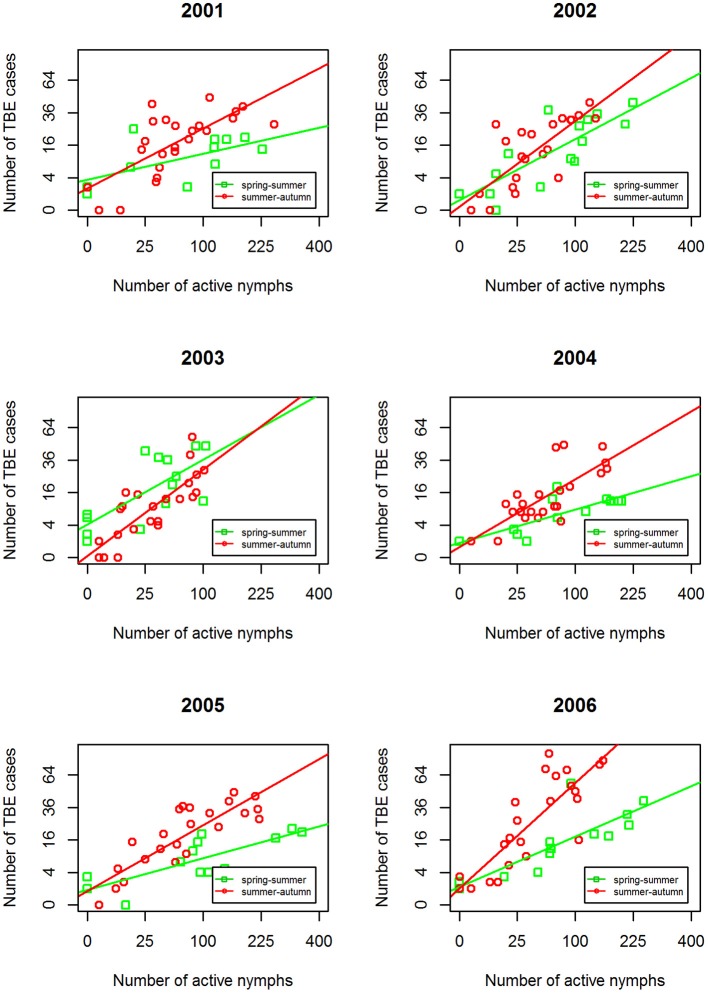
Inter-seasonal comparison of the linear regression relationship between numbers of host-questing Ixodes ricinus nymphs and cases of TBE. Square root transformation was used for both axes together with a 3-week shift in alignment.